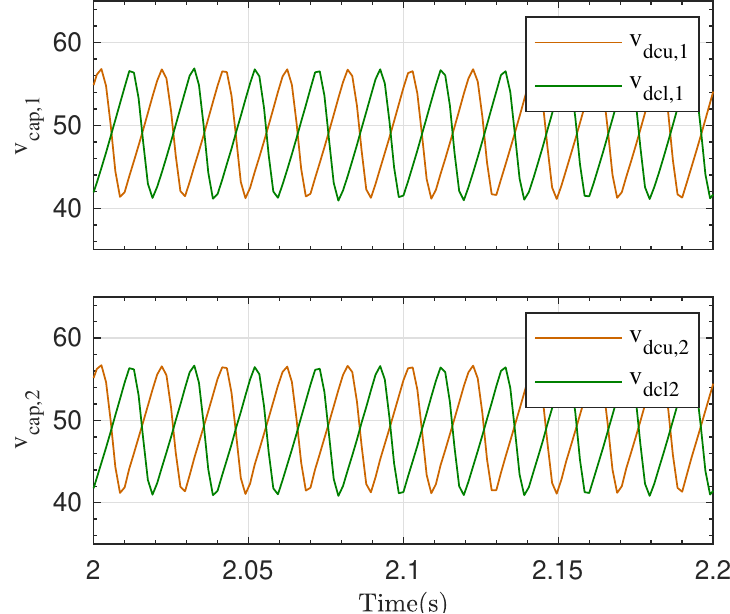
Figure 14. Steady-state experimental results of capacitor voltage across each 3L-TNPC